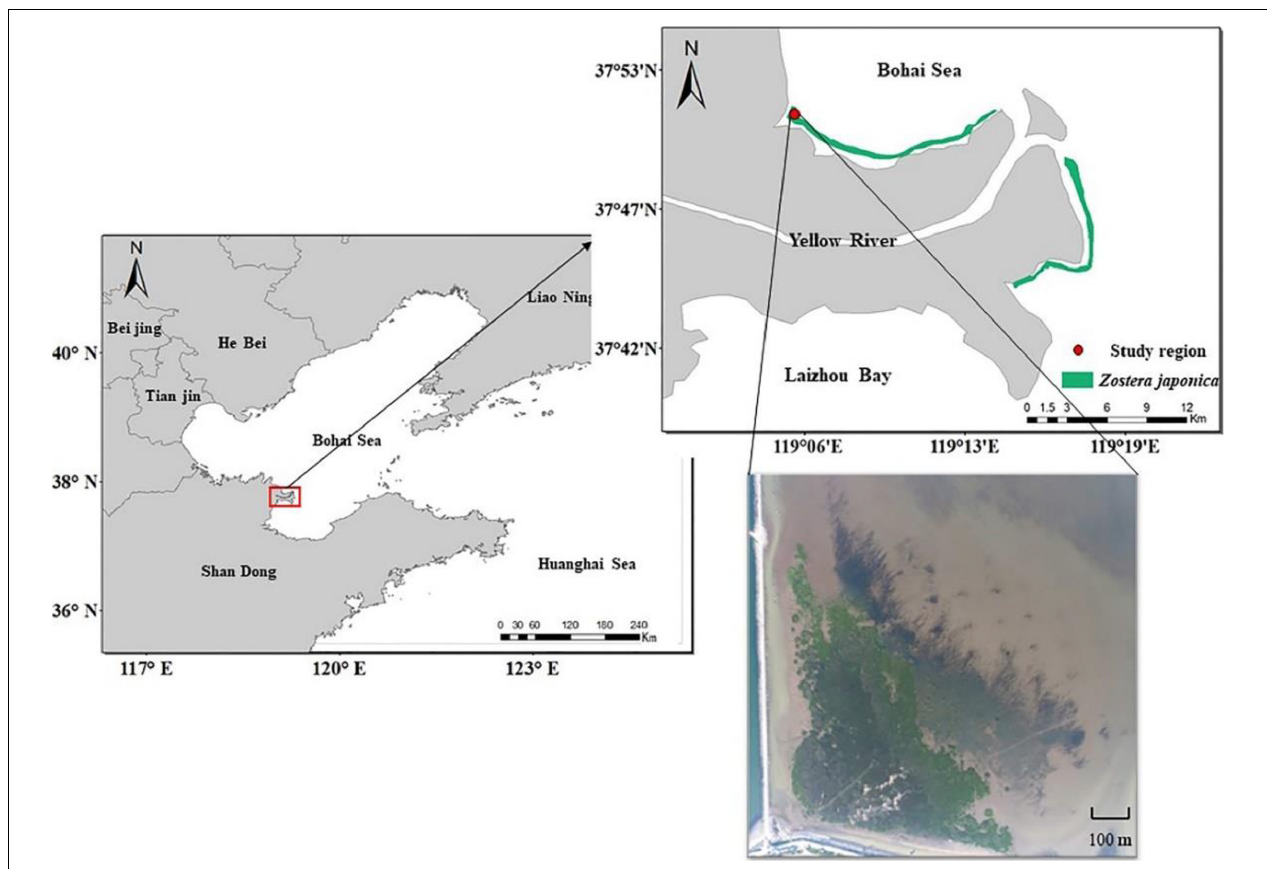
FIGURE 1 | Study region in the Yellow River